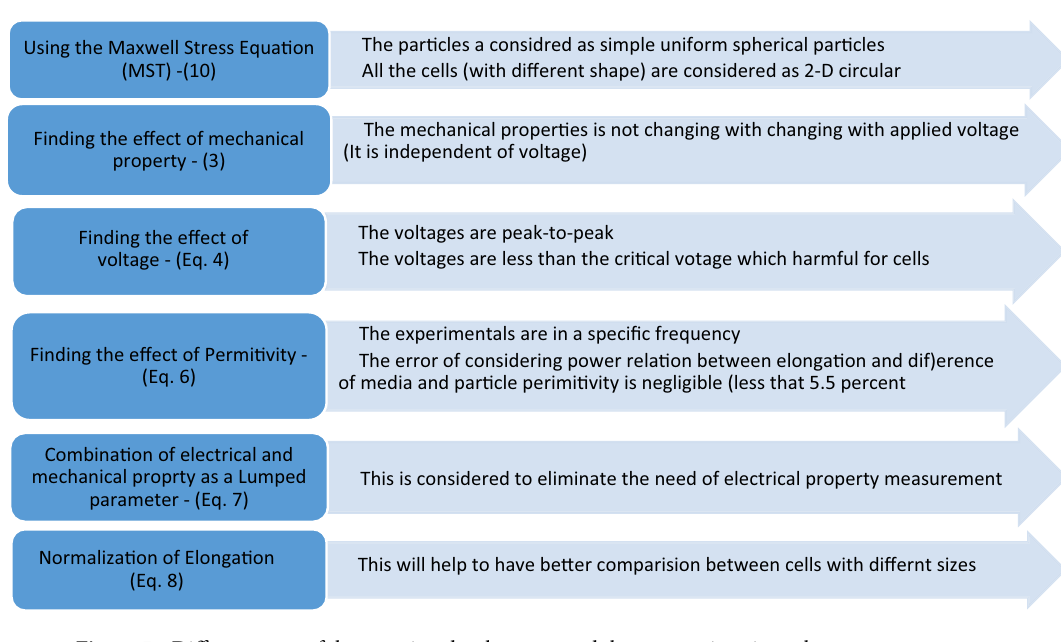
Figure 5. Different steps of the equation development and the assumptions in each